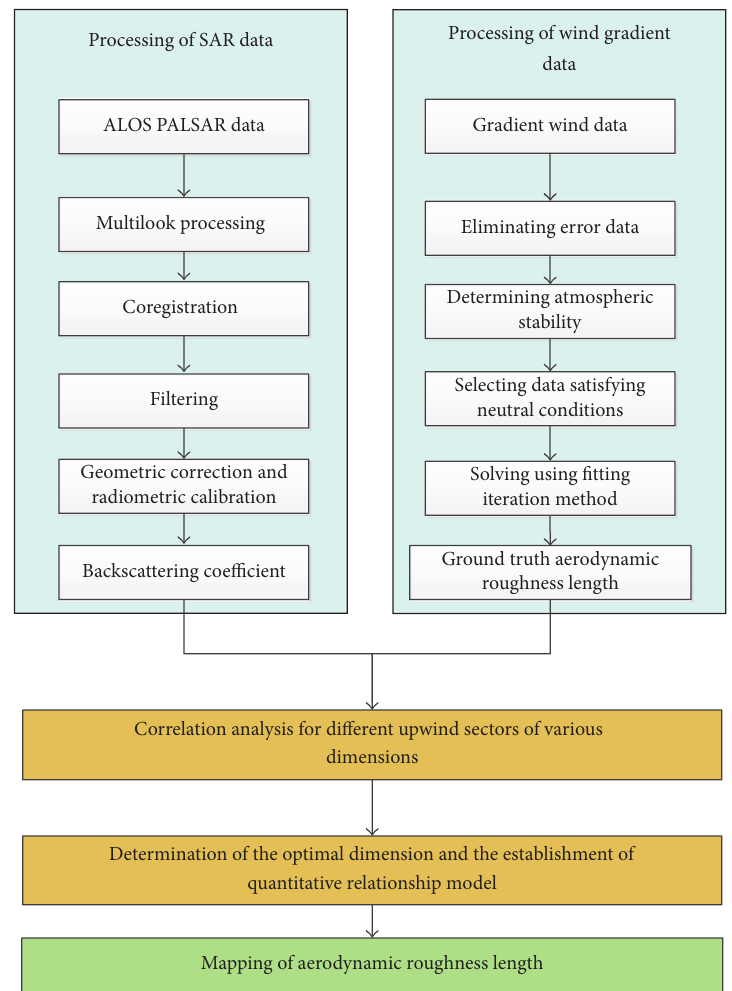
Figure 4: A flowchart of aerodynamic roughness length estimation from ALOS PALSAR